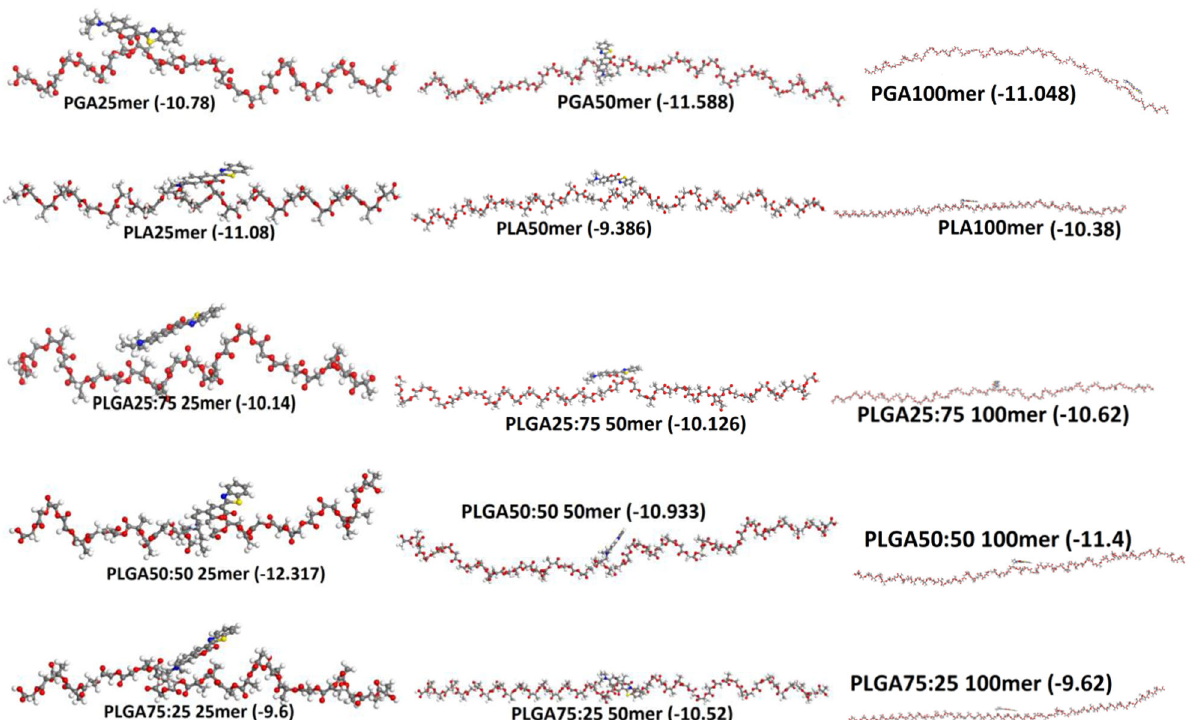
fi gure. Exact values of the conformations have been stated in Sup- plementary Table S2